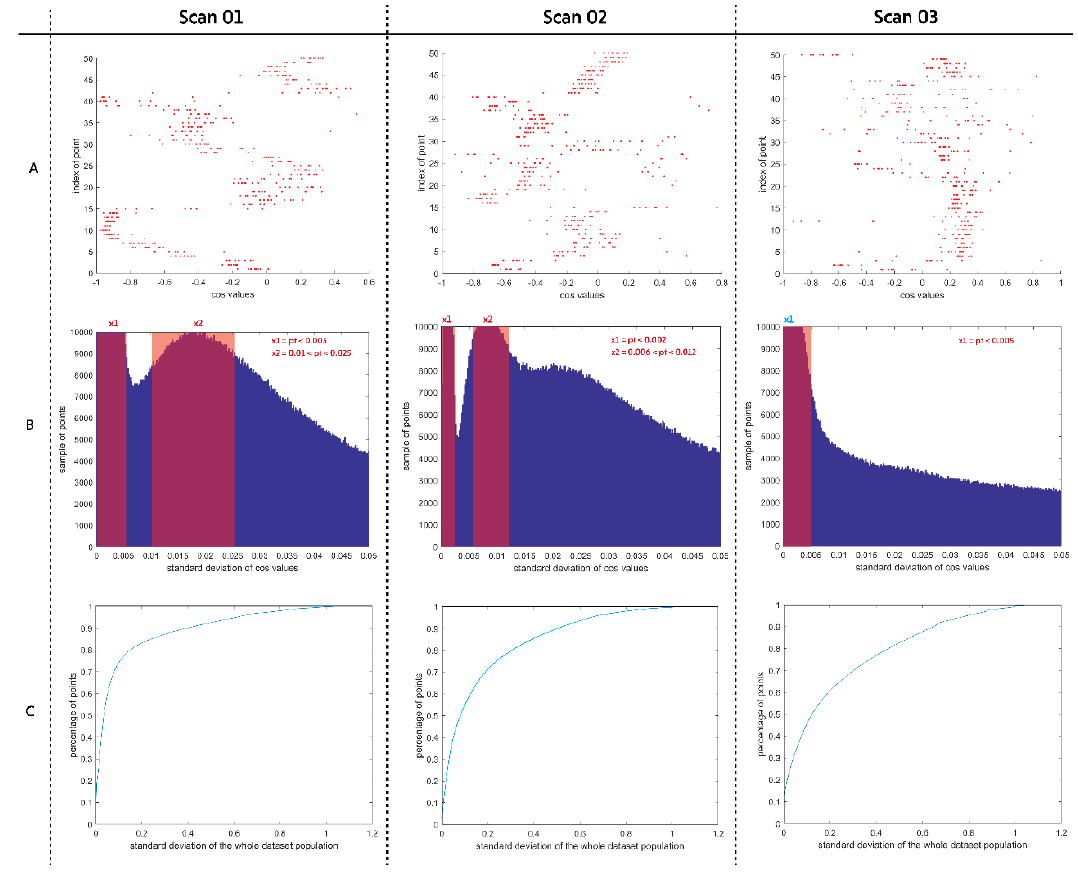
Figure 9. Dataset correction ( A ). Point distributions based on cosine values of each incident angle ( B ). The standard deviation of cosine values based on a group sample of points ( C ). The standard deviation of the whole dataset population.